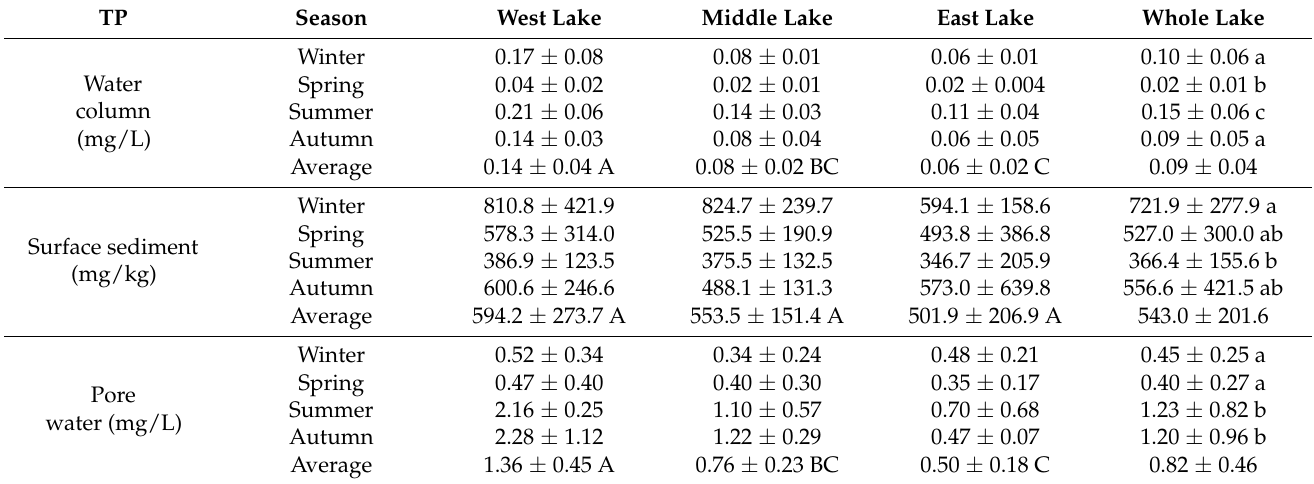
Table 3. The averages and standard deviation (SD) of TP concentrations in different seasons of the water column, surface sediment, and pore water in Lake Yangcheng. Different letters represent statistically significant differences according to Fisher’s PLSD test ( p < 0.05). Upper case letters (row): among different areas (west, middle, and east); lower case letters (column): among different seasons (winter, spring, summer, and